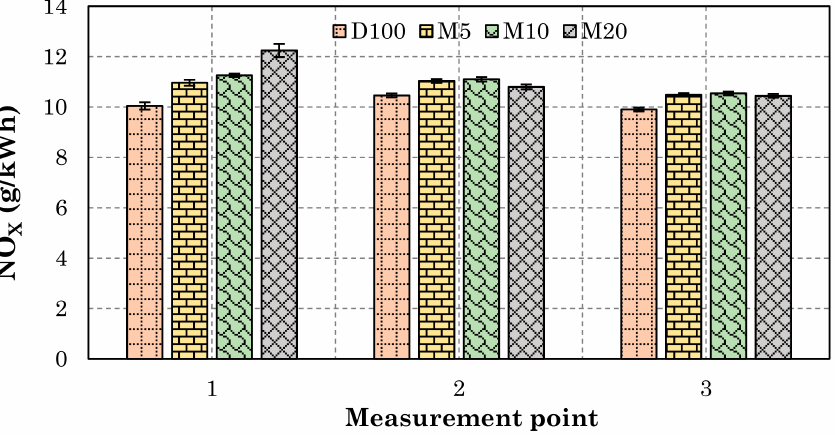
Figure 11. Specific NO X emissions for all test fuels at all measurement points (error bars represent the standard